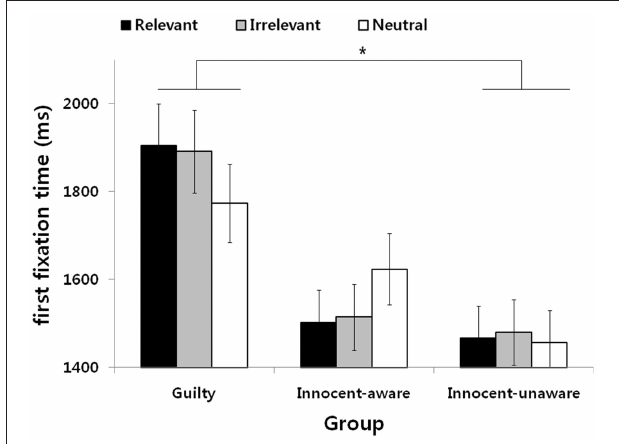
FIGURE 3 | First fixation time for the three stimulus types with respect to the subject group. Means and standard error (* p < 0.05) are